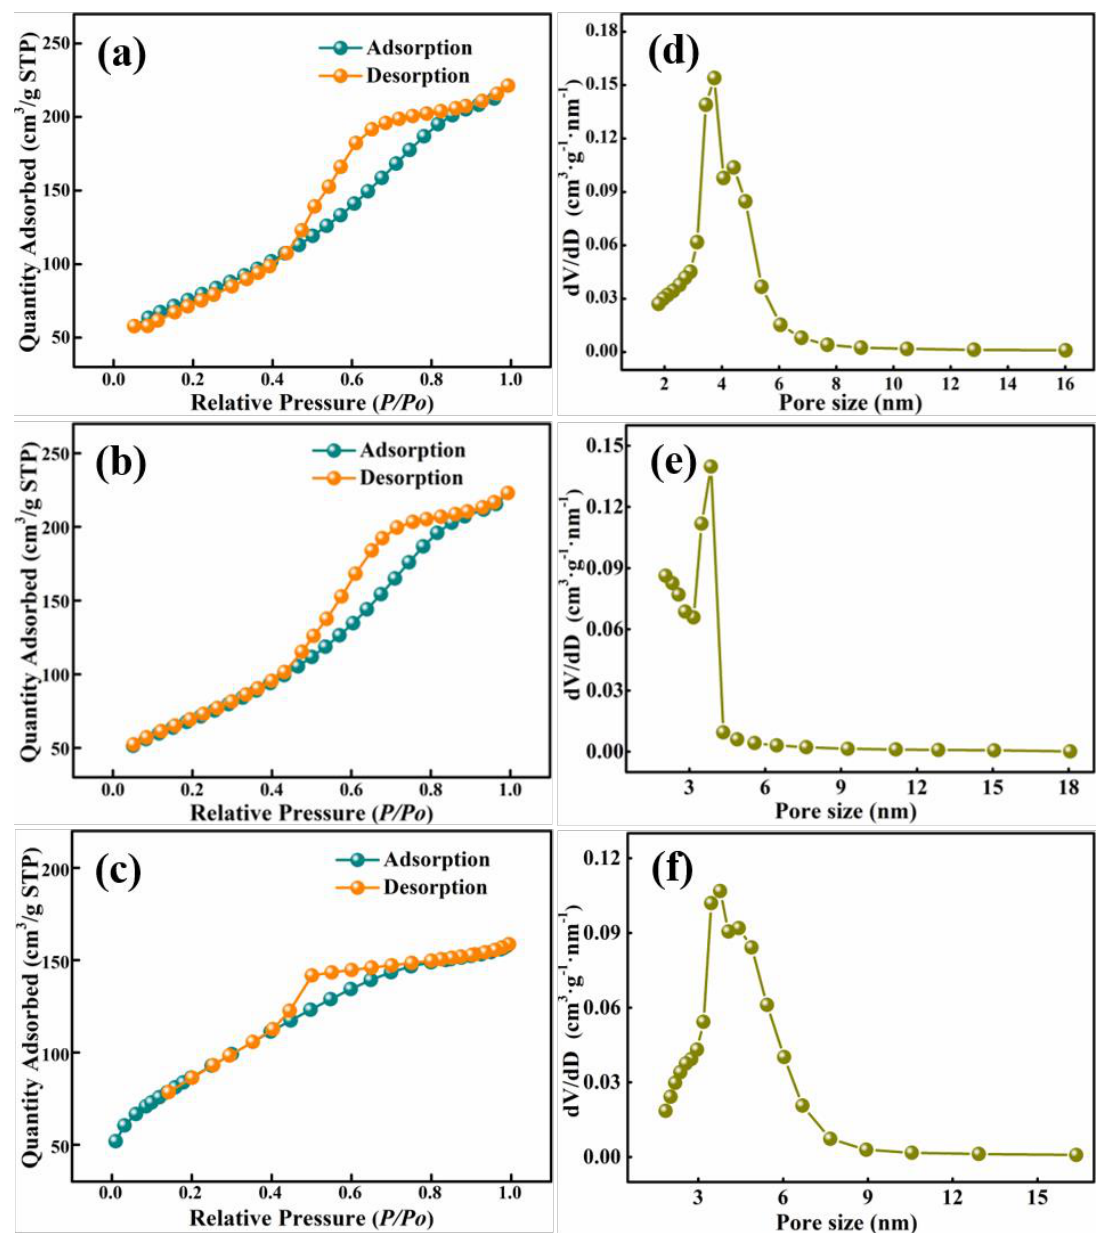
Figure 4. Nitrogen adsorption and desorption isotherms ( a ): (NH 4 ) 2 CO 3 , ( b ): CH 3 COONH 4 , ( c ): (NH 4 ) 2 C 2 O 4; pore size distribution curves of different ammonium salts used in the products ( d ): (NH 4 ) 2 CO 3 , ( e ): CH 3 COONH 4 , ( f ): (NH 4 ) 2 C 2 O 4